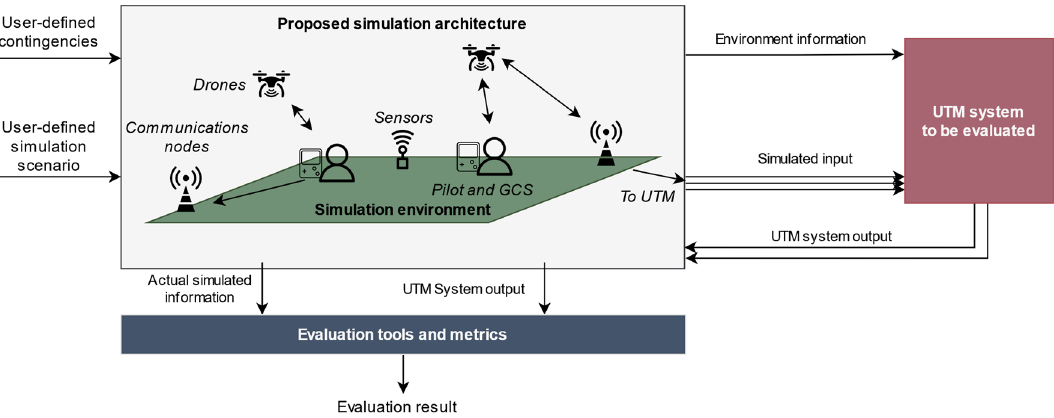
Figure 1. Operation of the simulation architecture proposed in [3]. Extracted from [3], with